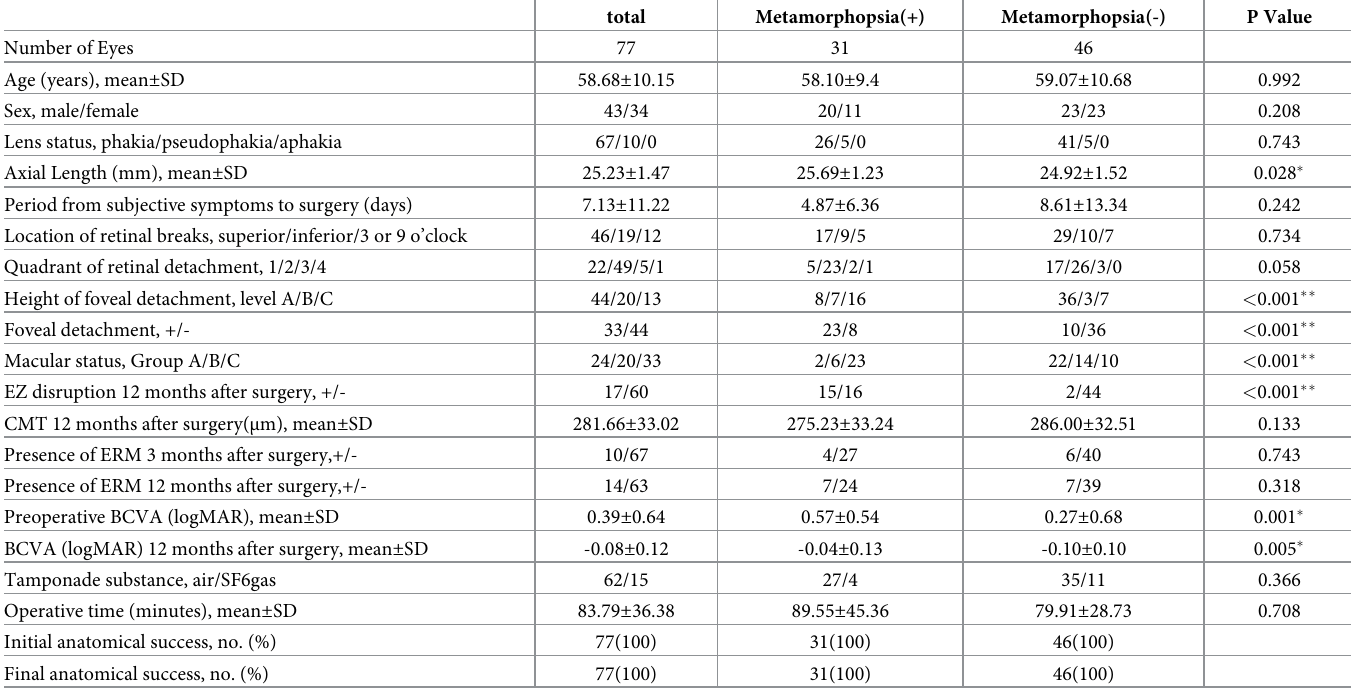
Table 1. Comparison of the demographic data of patients with or without postoperative metamorphopsia. total Metamorphopsia(+) Metamorphopsia(-) P